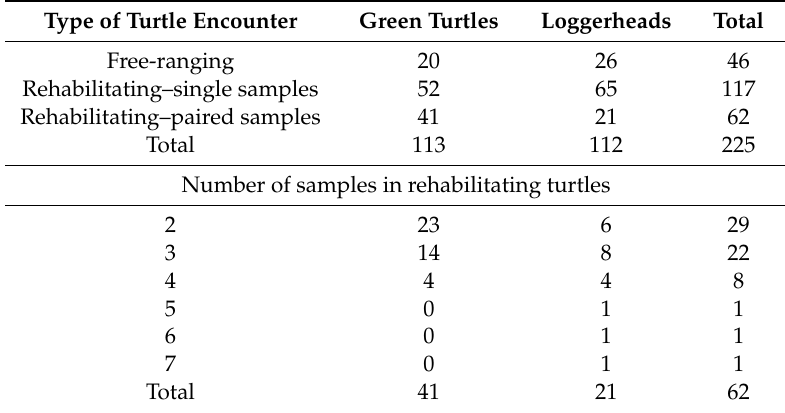
Table 1. Number of sea turtles sampled for this study, according to species and circumstances of encounter. Type of Turtle Encounter Green Turtles